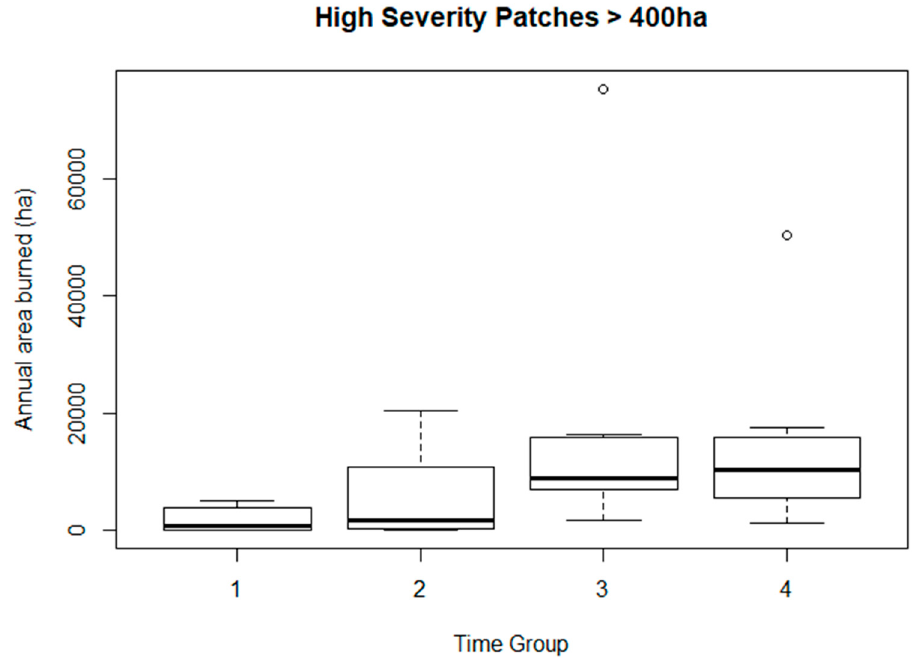
Figure 2. Annual area of large ( > 400 ha) CESF patches in the four time periods (see Tables 1 and 2 for time periods). Table 2. Critical values (q 0.05, 4 ), absolute di ff erence between mean of ranks. ( | A - B | ), standard errors (SE), and test statistics (Q) to assess statistical significance at α = 0.05 of any di ff erences among the four-time groups (1 = 1984–1991, 2 = 1992–1999, 3 = 2000–2007, and 4 = 2008–2015) for the size of individual CESF patches > 400 ha using the Dunn non-parametric test for multiple comparisons. The statistical significance of levels of Q are shown as “Y” (significant) or “N” (not significant). For time groups 1, 2, 3, and 4, n = 17, 46, 134, and 130 CESF patches > 400 ha, respectively.